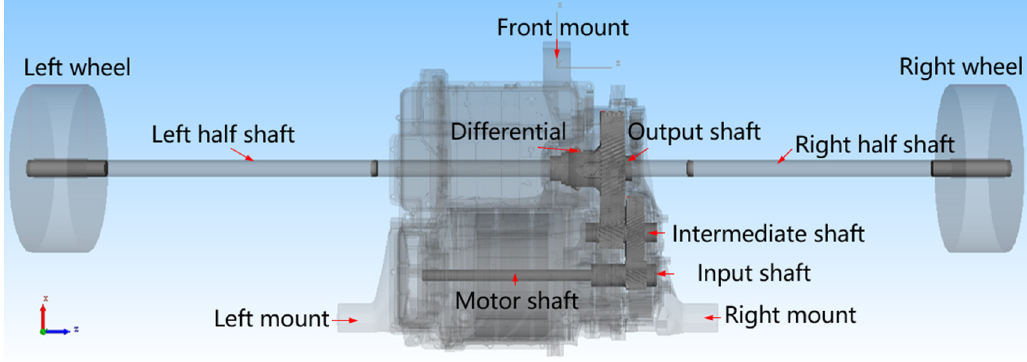
Figure 1. Overall structure of the powertrain system.